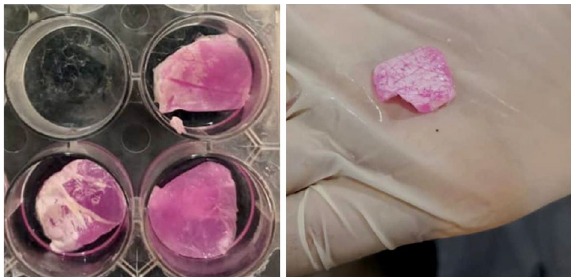
Figure 10. The cell encapsulation device. 1.5 × 1.5 cm nanofibrous packet containing cells and